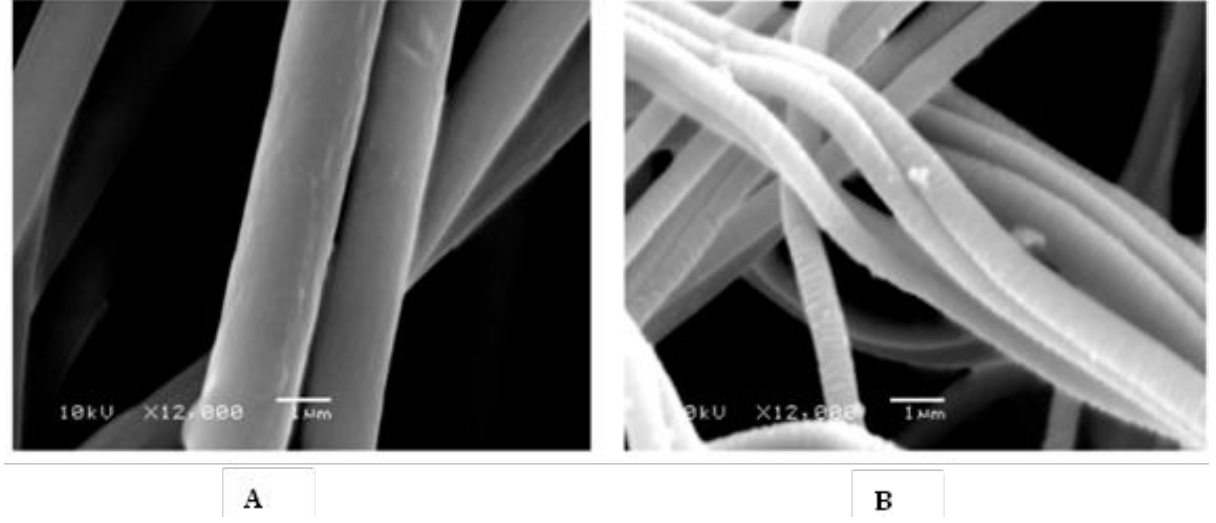
Figure 12. SEMs of ( A ) core – sheath PANI/PMMA electrospun nanofibers and ( B ) electrospun PANI nanofibers after removal of PMMA [182]. Reprinted with permission from Ref. [182]. Copyright 2012.